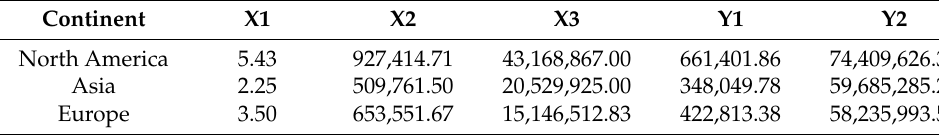
Table 4. The descriptive statistics of the collected by group of